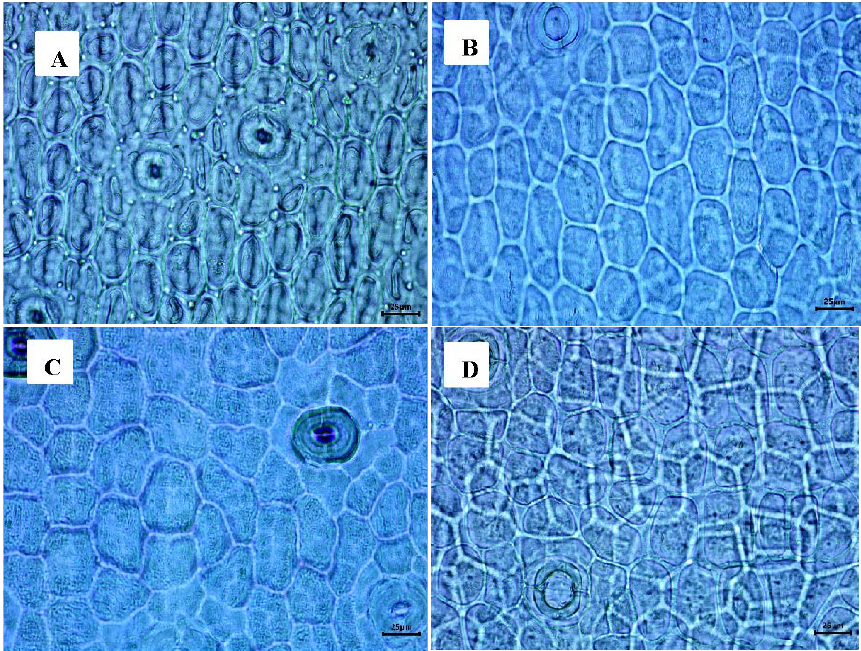
Figure 5. Area of abaxial epidermal cells. ( A ) Cattleya mossiae 600 to 800 μm 2 . ( B ) Laelia crawshayana 801 to 1000 μm 2 . ( C ) Laelia anceps 1001 to 1200 μm 2 . ( D ) Laelia autumnalis 1201 to 1400 μm 2 .